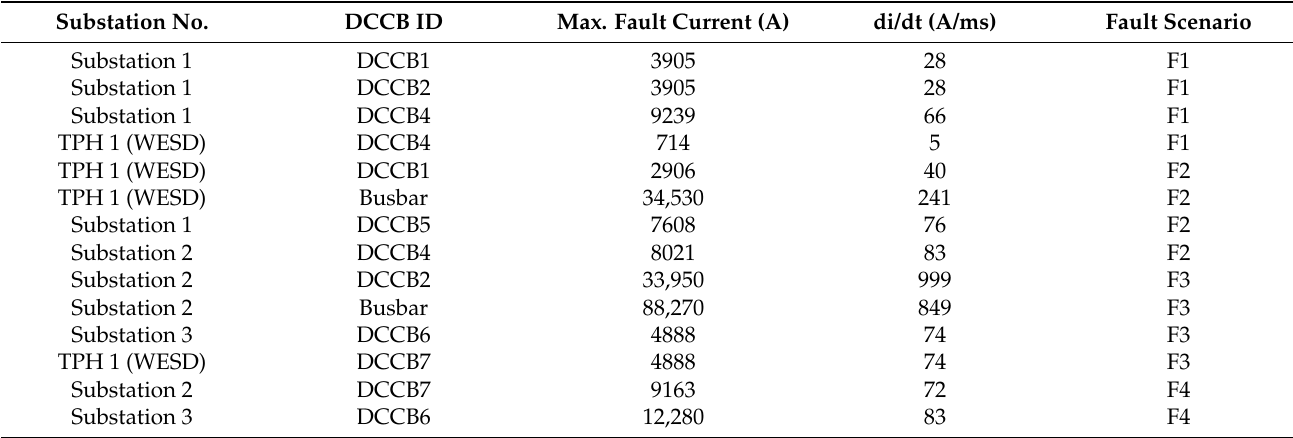
Table 14. Bolted fault simulation